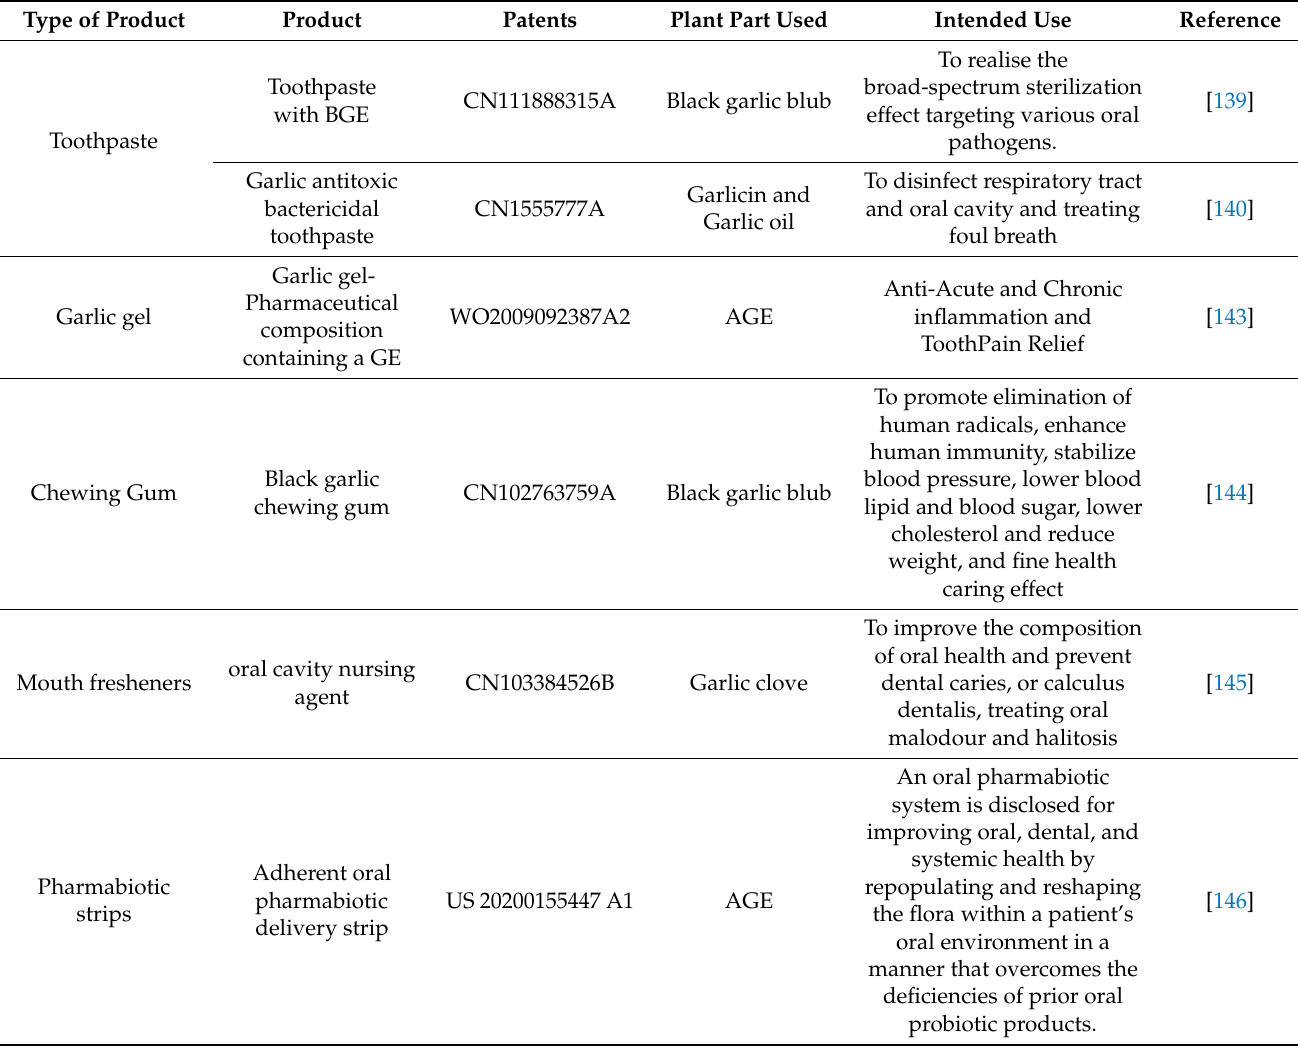
Table 4. Various innovative products developed from